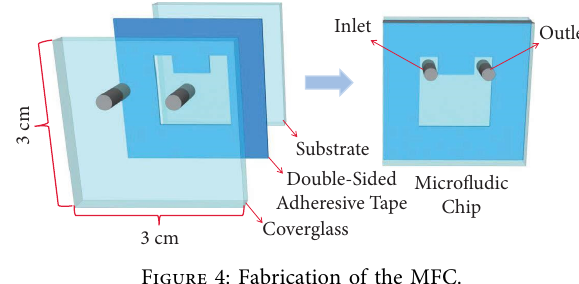
Figure 4: Fabrication of the MFC.